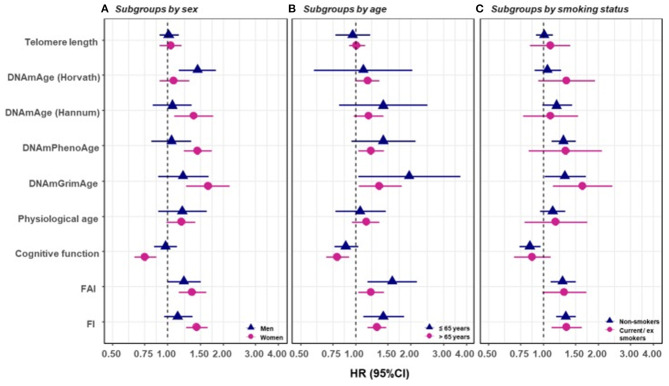
Survival analyses of baseline BAs with the risk of all-cause mortality in subgroups classified by sex, baseline smoking status, and baseline age (one-BA models). A total of 845 individuals were included to estimate the mortality associations of BAs in subgroups. We used Cox regression models to estimate the change in mortality risk associated with a one-SD increment of the respective BA at baseline assessment (one-BA models). All models controlled for sex, educational attainment, smoking status, and BMI, stratified by participants' birth year, and accounted for left truncation and right censoring. Attained age was used as the time-scale and thus age was inherently adjusted for. BA-mortality associations were illustrated in the forest plot (A–C), in which points and horizontal lines denoted HRs (95% CIs) and point shapes and colors represented subgroups. The associations of BAs with mortality risk were generally stronger in women (except for Horvath DNAmAge and physiological age), more pronounced in the younger individuals (except for Horvath DNAmAge, physiological age and cognitive function), and a bit stronger in current or ex-smokers (for Horvath DNAmAge and DNAmGrimAge). BA, biological age; DNAmAge, DNA methylation age estimator; FAI, functional aging index; FI, frailty index; CA, chronological age; HRs (95%CIs), hazard Ratio (95% Confidence Interval). The figure and its legend are reproduced from the article by Li et al. (2020) distributed under the terms of the Creative Commons Attribution License. Copyright © 2020, Li et al.